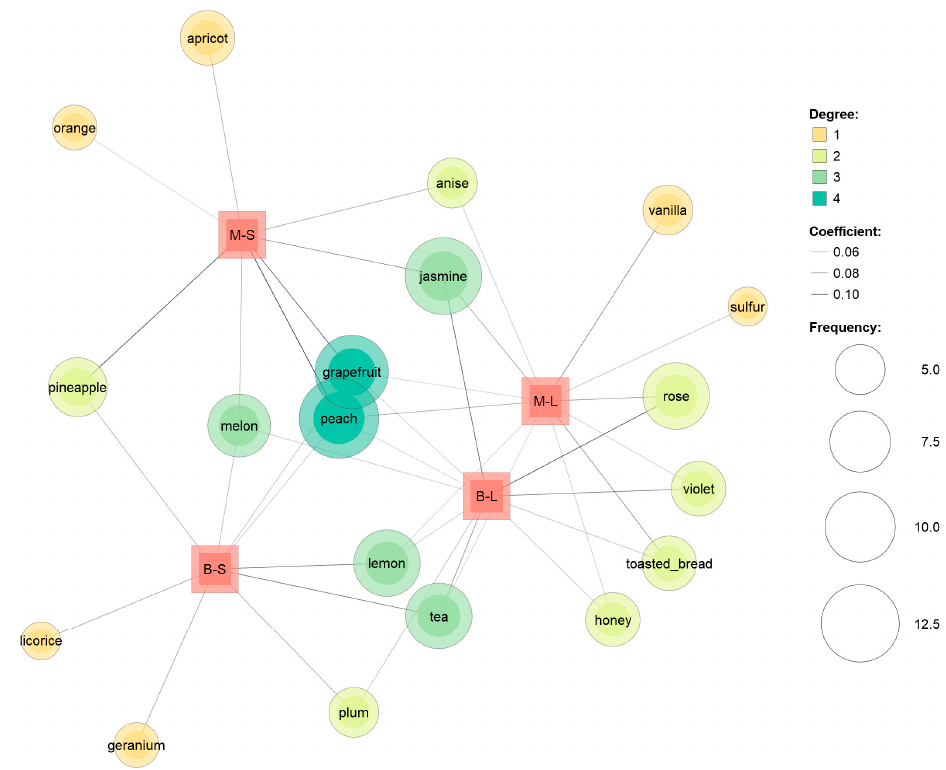
Figure 4. Co-occurrence network of the check-all-that-apply (CATA) attributes of the wines ob- tained by the combination of grape cultivars (M—Minutolo, B—Bombino) and yeast starters (S— Saccharomyces cerevisiae , L— Lachancea thermotolerans ). The size of the circles represents the term frequency; the color of the circles represents the number of connected subjects (degree); the width of the connection lines is proportional to the Jaccard coefficient, indicating the strength of connections (see figure